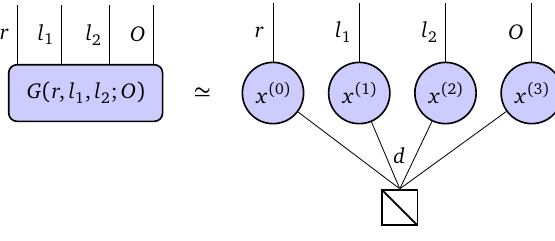
Figure 4: Graphical representation of the tensor decomposition in Eq. (12). Each circle or rectangle with N legs represents a N -way tensor. When two tensors share a leg, the summation over the corresponding index must be taken. A rectangle with a diagonal line represents a identity tensor